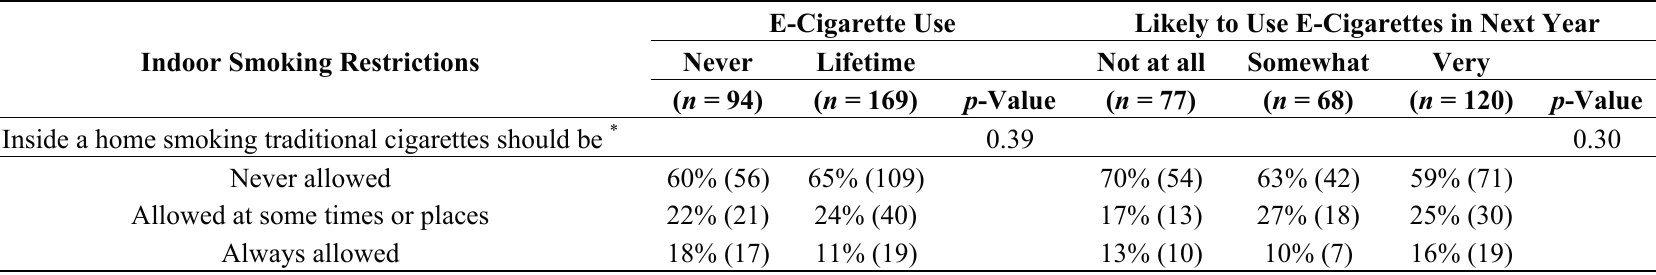
Table 4. Associations between support for indoor smoking bans, lifetime e-cigarette use, and behavioral